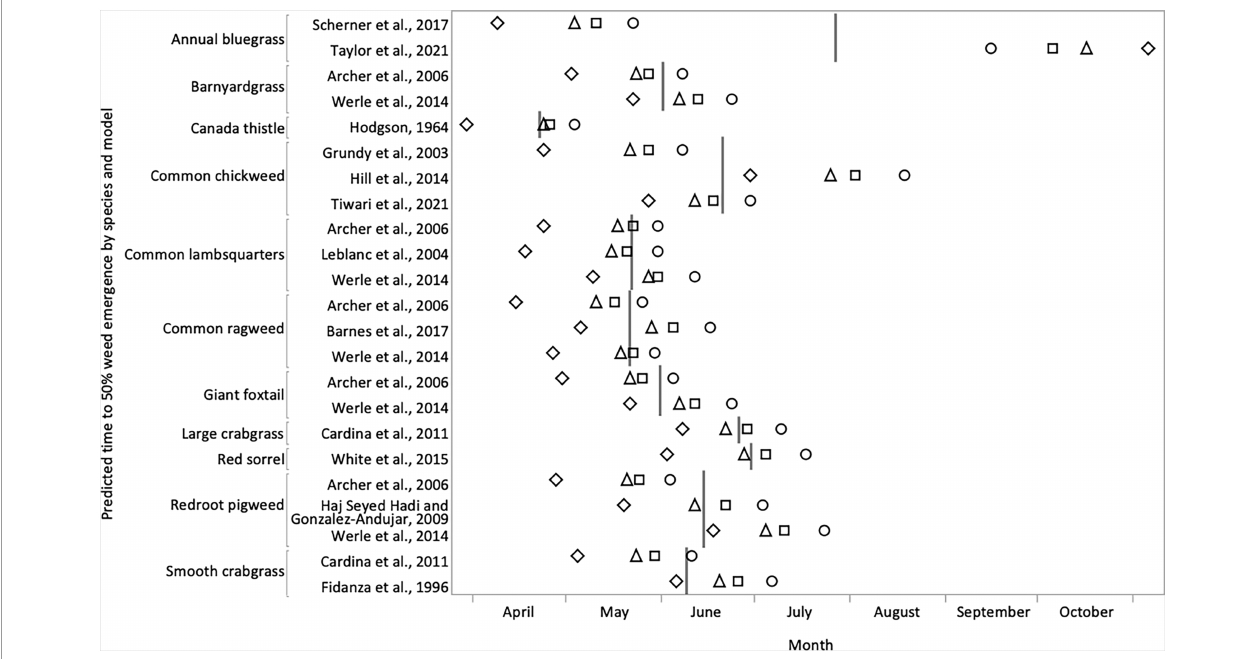
FIGURE 2 | Predicted time to 50% (peak) weed emergence based on growing-degree-day models. Emergence was modelled from a range of USDA Plant Hardiness Zones representing most of Northeast USA. Zones include 4a (circles), 5a (squares), 6a (triangles), and 7a (diamonds). Vertical lines represent the mean predicted time to 50% emergence across presented data for each species. Models were not available for all the species we